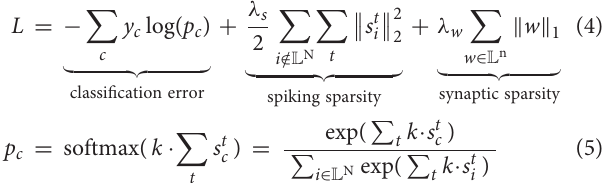
term measures the classification error through softmax and cross- entropy functions. The second and third terms achieve spiking sparsity and synaptic sparsity,